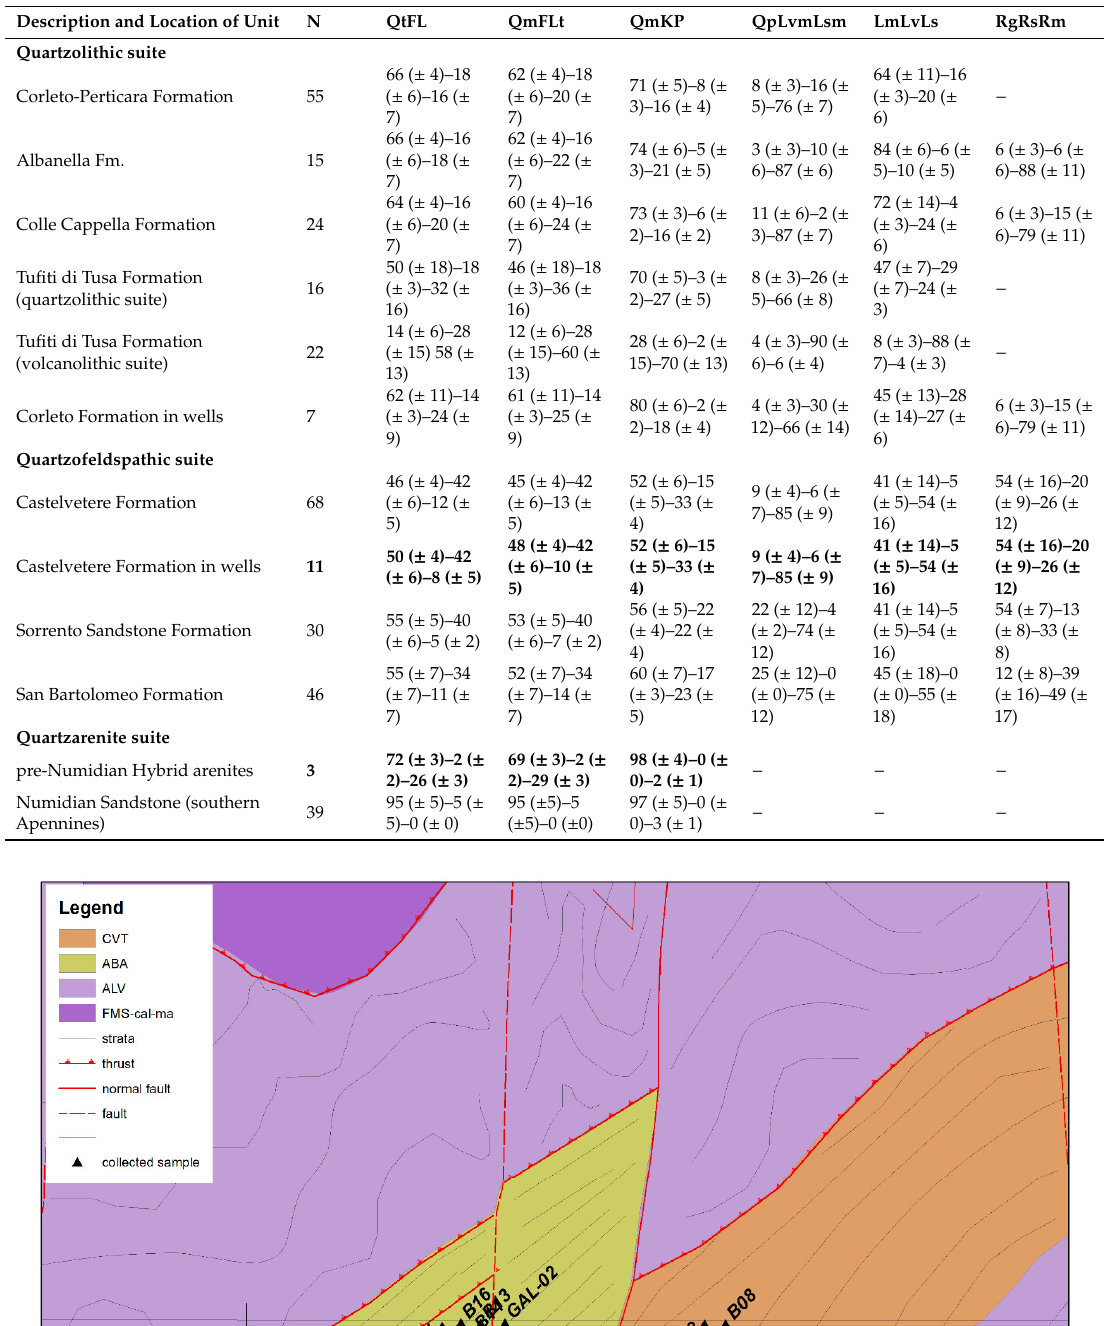
Table 5. Mean detrital modes of selected sandstone suites of the southern Apennines correlated with well data of studied successions. Data source from Critelli (2018).